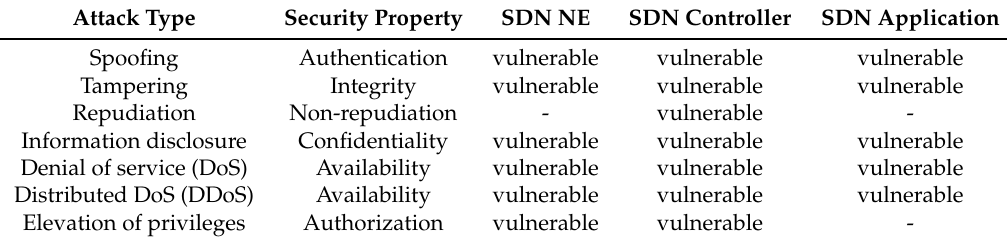
Table 1. Summary of SDN security